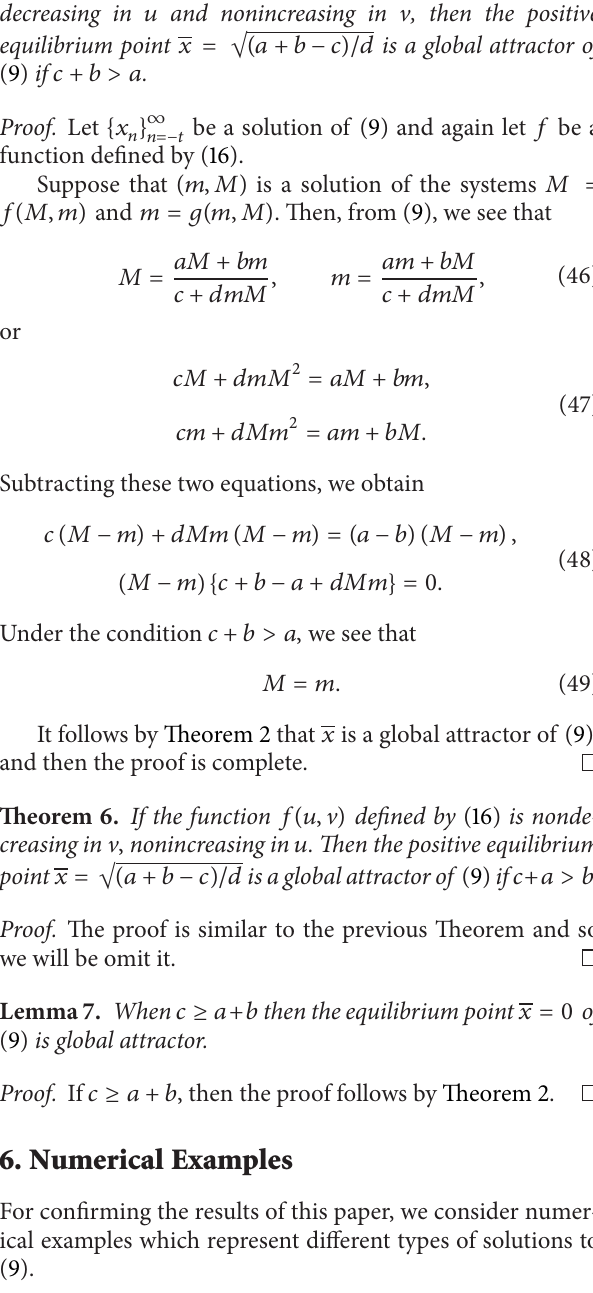
Figure 3: It shows the periodicity of the solution of (9) when 𝑙 = = 𝑥 = 𝑝, 𝑥 = 𝑥 = 𝑞, 𝑎 = 9, 𝑏 = 13, 𝑐 = 3, 𝑘 = 1, 𝑥 −3 −1 −2 0 0.1, and 𝑑 = 2